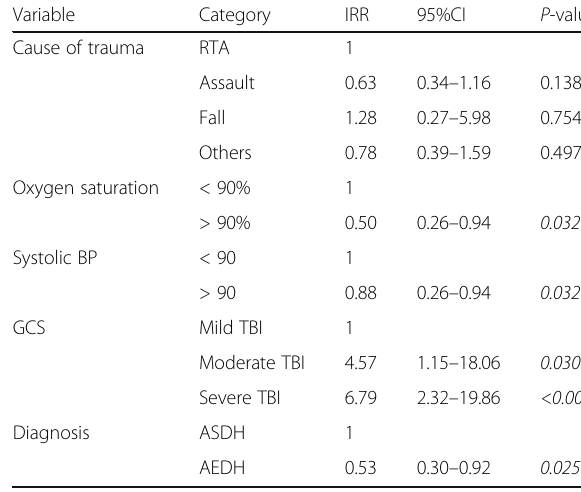
Table 2 Bivariate modified Poisson regression analysis to determine the factors that influence unfavorable outcomes Variable